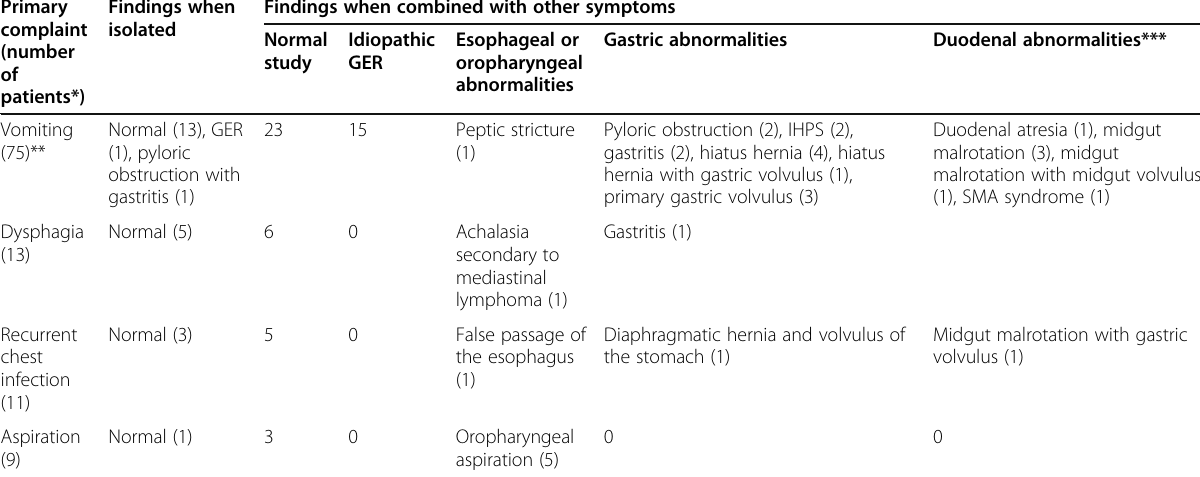
Table 1 UGI series findings in relation to patients ’